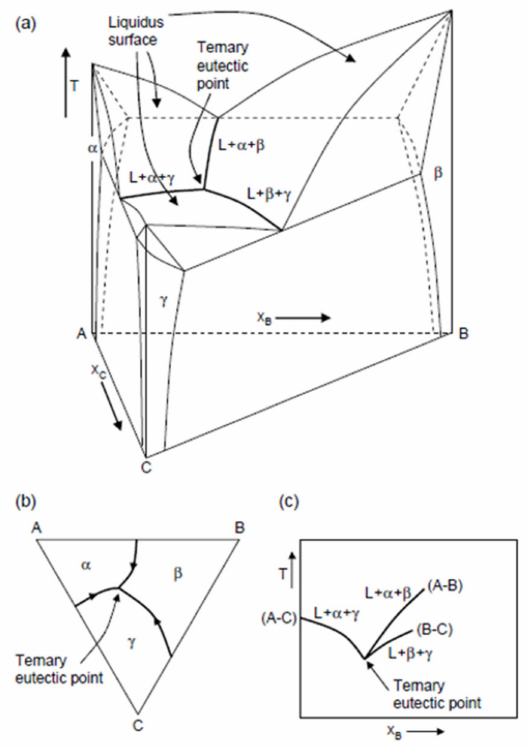
Figure 5. Different representations of a ternary diagram ( a ) 3-axes phase diagram of a ternary system, ( b ) projection of the liquidus univariate lines on a composition-composition diagram and ( c ) on a temperature-composition diagram after